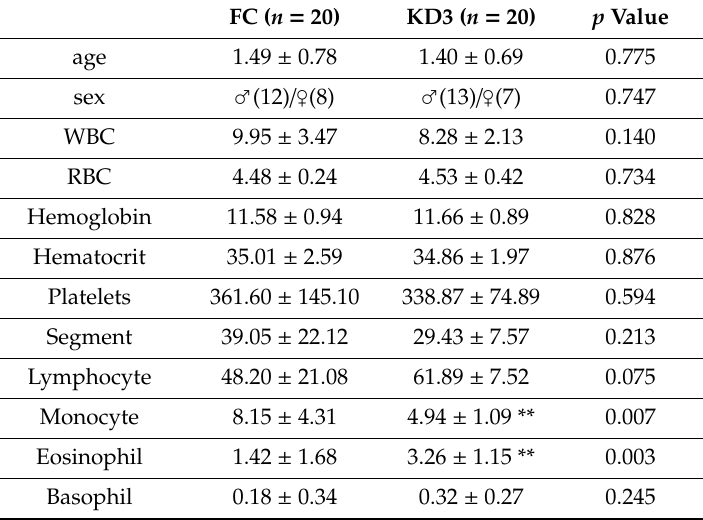
Table 5. Demographic and Clinical Characteristics of Enrolled